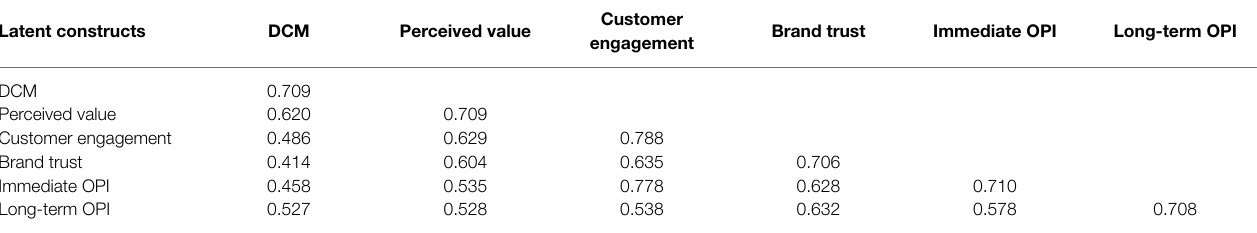
TABLE 3 | Discriminant validity (correlations between constructs). Latent constructs